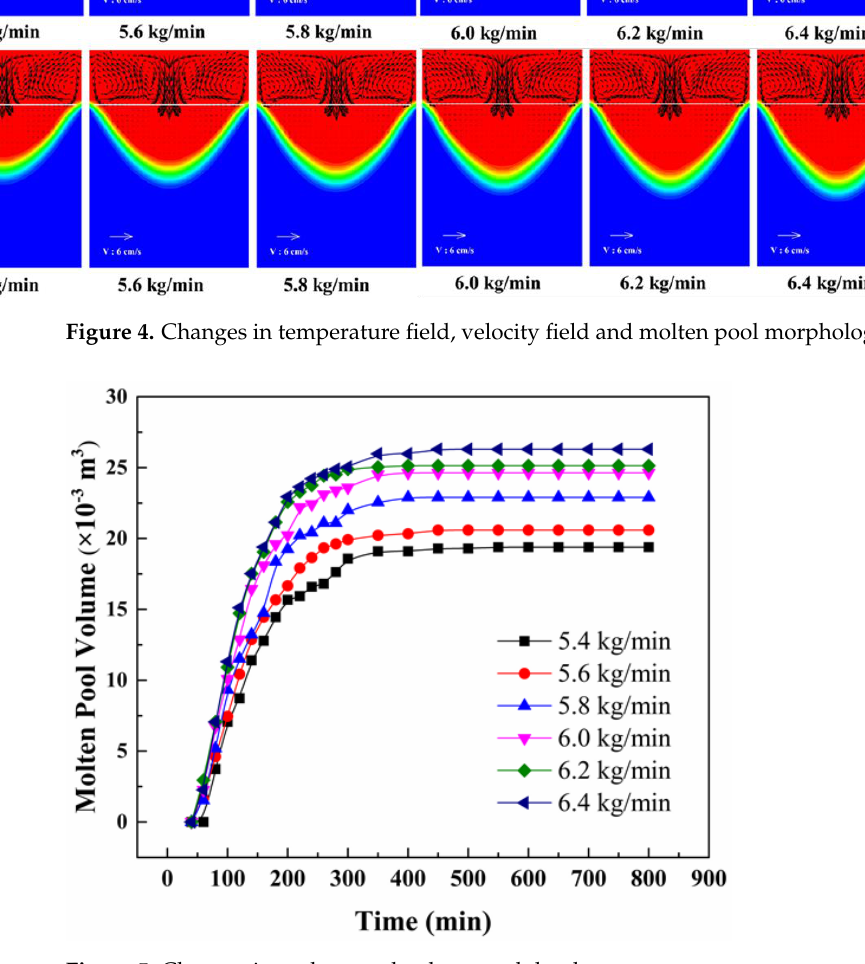
Table 3. Average temperature and solidification structure of remelted ingot under different pro- cess